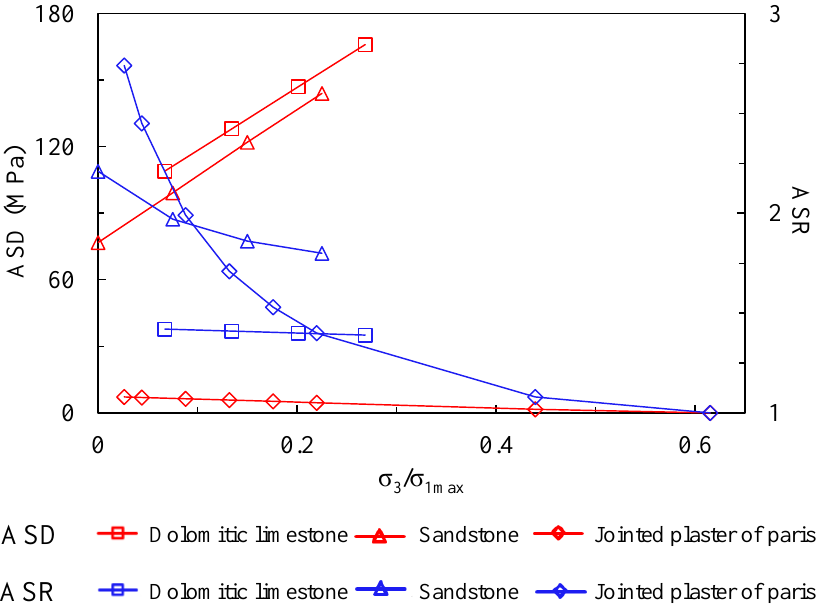
Figure 8. The relation between anisotropy degree of anisotropic rock mass and confinement. Despite isotropization under high confinement using the index of anisotropic strength ratio, i.e., the absolute value between potential maximum and minimum compressive strength, i.e., the anisotropic strength difference (ASD) (Equation (8)) can reflect whether the rock mass can possess a total strength isotropy when the confinement is high